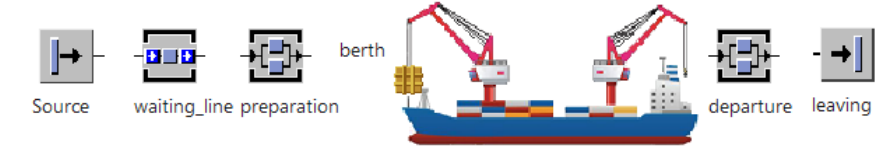
Figure 5. Ship arrival & departure process.